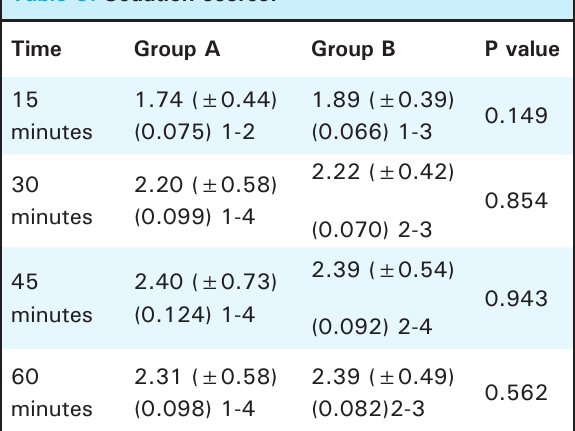
Table 5. Sedation scores.